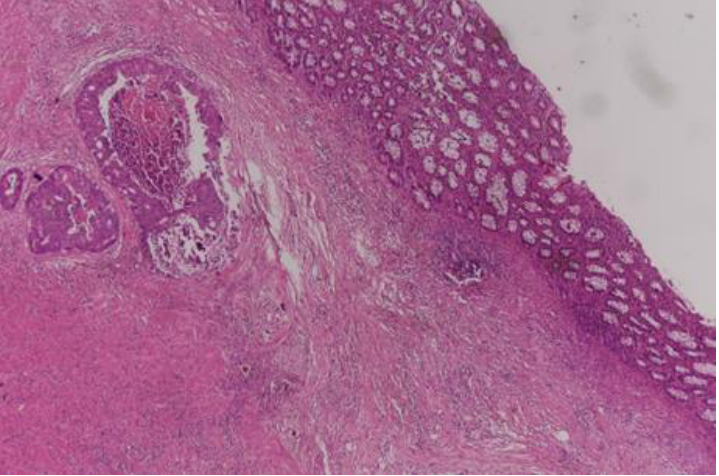
Figure 4. Minimal pathological response (TRG2); x 40 HE; Tumor in the submucosa, small foci of calcification.